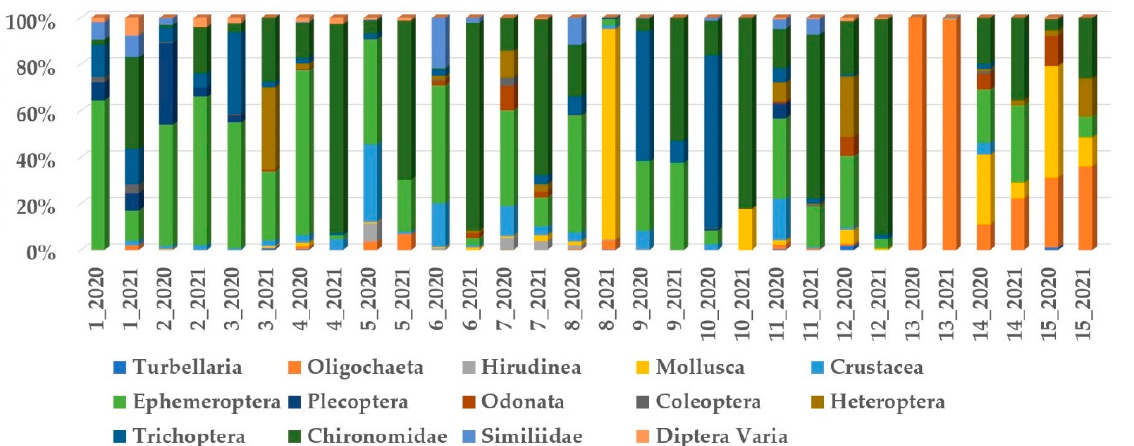
Figure 5 . Percentage ratio of the major taxonomic groups at the studied sites in 2020 and 2021.